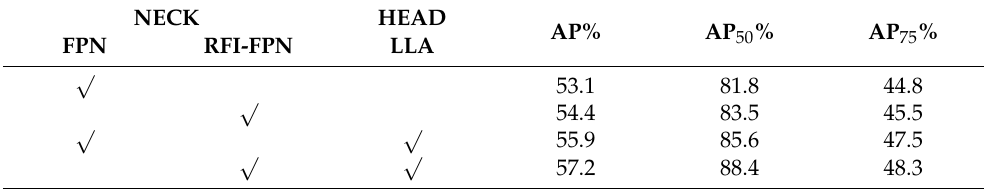
Table 5. Compared results of ablation experiment.